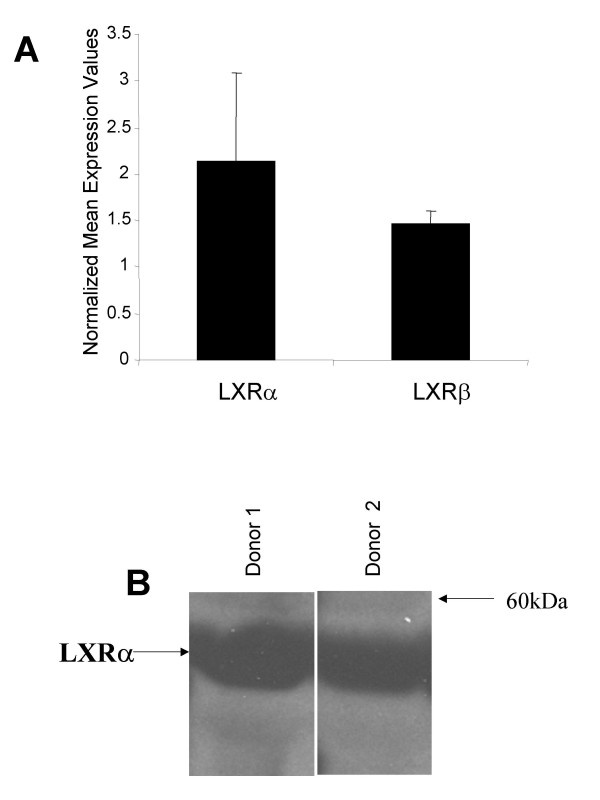
LXRs are expressed in peripheral blood cells. (A) RNA from peripheral blood mononuclear cells obtained from normal human donors was assayed for LXRα and LXRβ transcript levels using qPCR. Expression values were normalized to GAPDH levels, represented as the mean +/- SEM. (B) LXRα protein levels in protein extracts from PBMCs from these same donors were detected by Western blotting using rabbit anti-human LXRα polyclonal antisera.